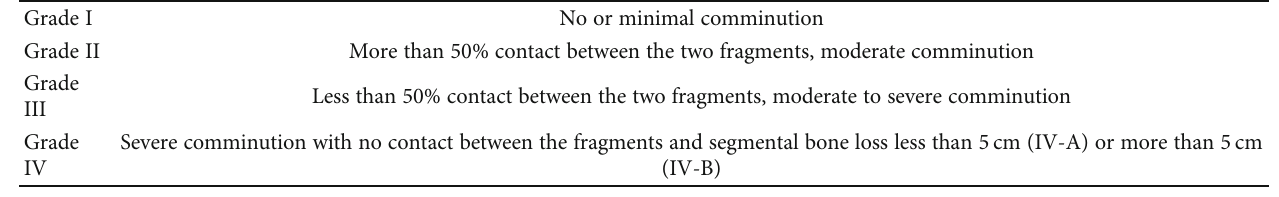
Table 1: Winquist-Hansen modi fi ed classi fi cation [8].